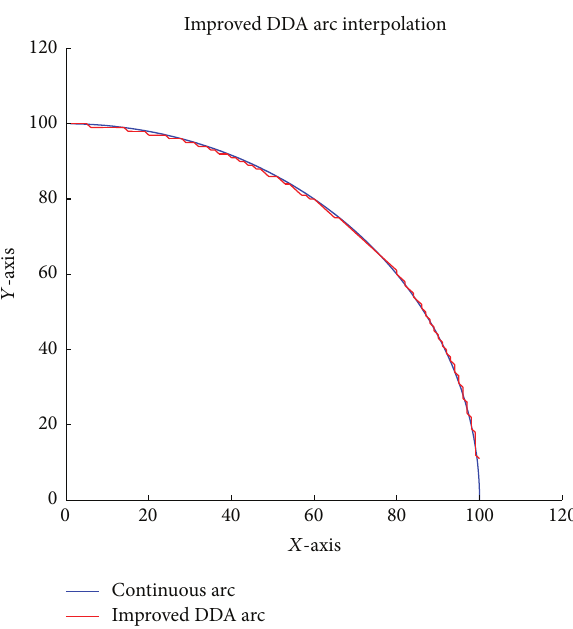
Figure 8: The sawteeth of DDA.